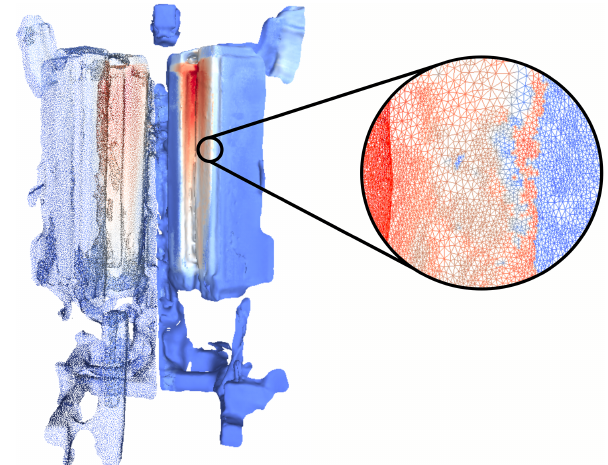
Figure 2. Illustration of the differences between a point cloud (left) and a surface reconstruction (right) with the triangle net in a close- up view for the exemplary application of a silicone extrusion line infrared heater. The full 3D thermogram consists of 1031567 points and 2050545 triangles.